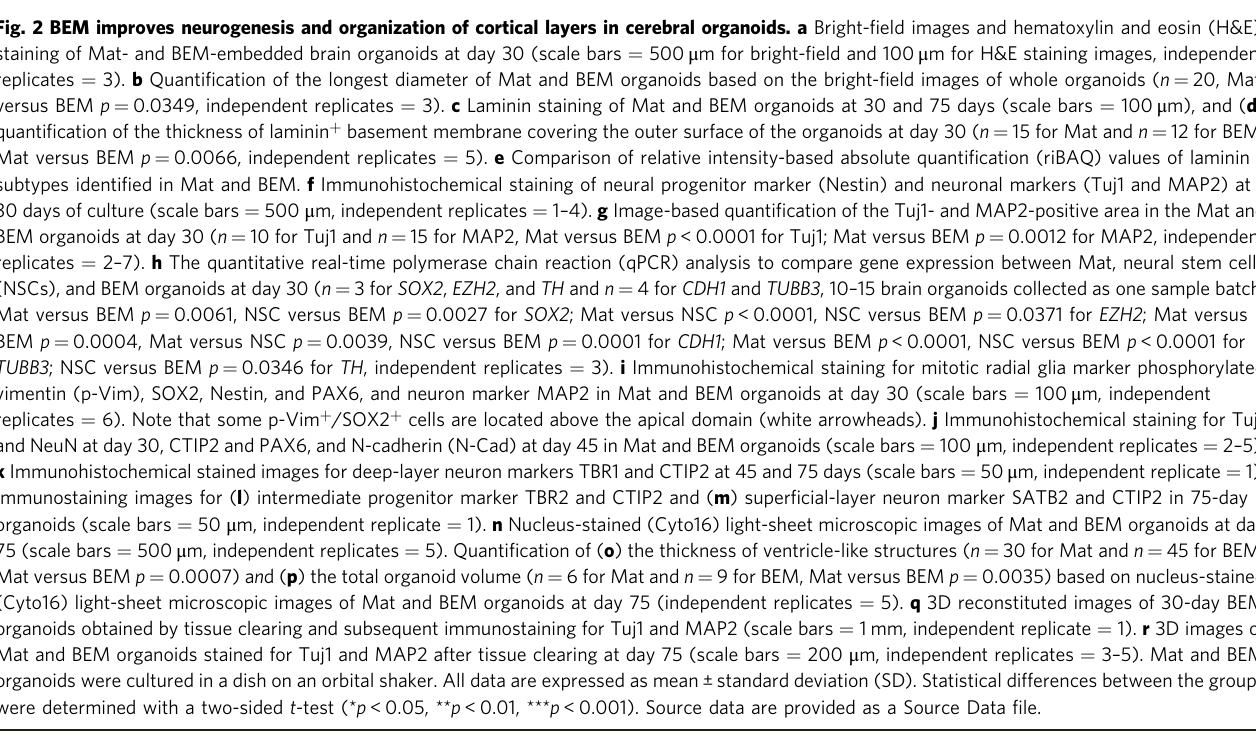
Fig. 2 BEM improves neurogenesis and organization of cortical layers in cerebral organoids. a Bright- fi eld images and hematoxylin and eosin (H&E) staining of Mat- and BEM-embedded brain organoids at day 30 (scale bars = 500 μ m for bright- fi eld and 100 μ m for H&E staining images, independent replicates = 3). b Quanti fi cation of the longest diameter of Mat and BEM organoids based on the bright- fi eld images of whole organoids ( n = 20,